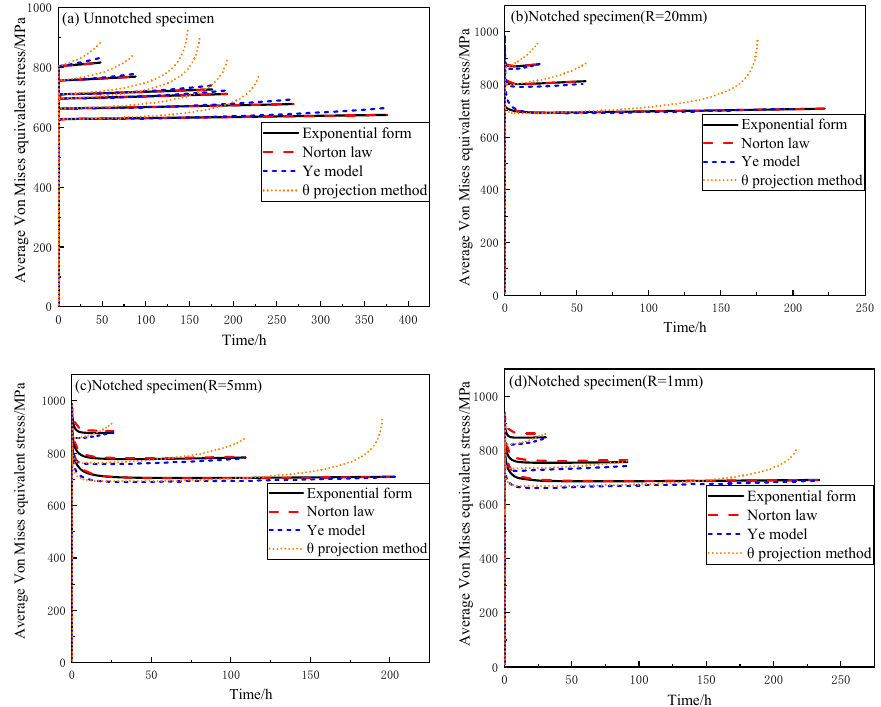
Figure 9. The AVES variation with time: ( a ) Unnotched specimen; ( b ) Notched specimen (R = 20 mm); ( c ) Notched specimen (R = 5 mm); ( d ) Notched specimen (R = 1 mm).